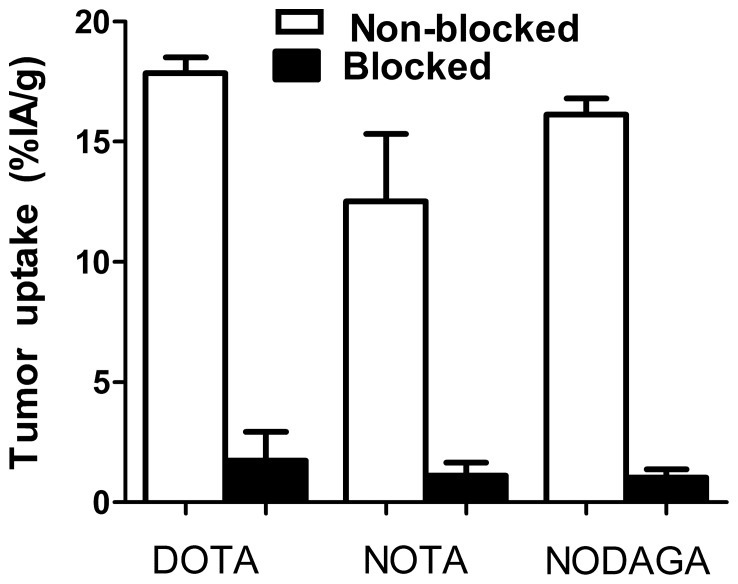
Specificity of targeting of SKOV-3 xenografts in BALB/C nu/nu mice using 68Ga-DOTA-ZHER2:S1, 68Ga-NOTA-ZHER2:S1 and 68Ga-NODAGA-ZHER2:S1 at 1h after injection.The total injected radiolabeled peptide dose per mouse was 3 µg (0.42 nmol). The blocked group was subcutaneously pre-injected with an excess amount (1000 µg, 150 nmol) of non-labelled ZHER2∶342 to saturate binding sites of HER2. Results are expressed as percentage of injected activity per gram of tissue (%IA/g) and presented as mean values for four mice and standard deviations. Uptake of radioactivity was significant lower (p<0.0005) for pre-saturated SKOV-3 tumors.